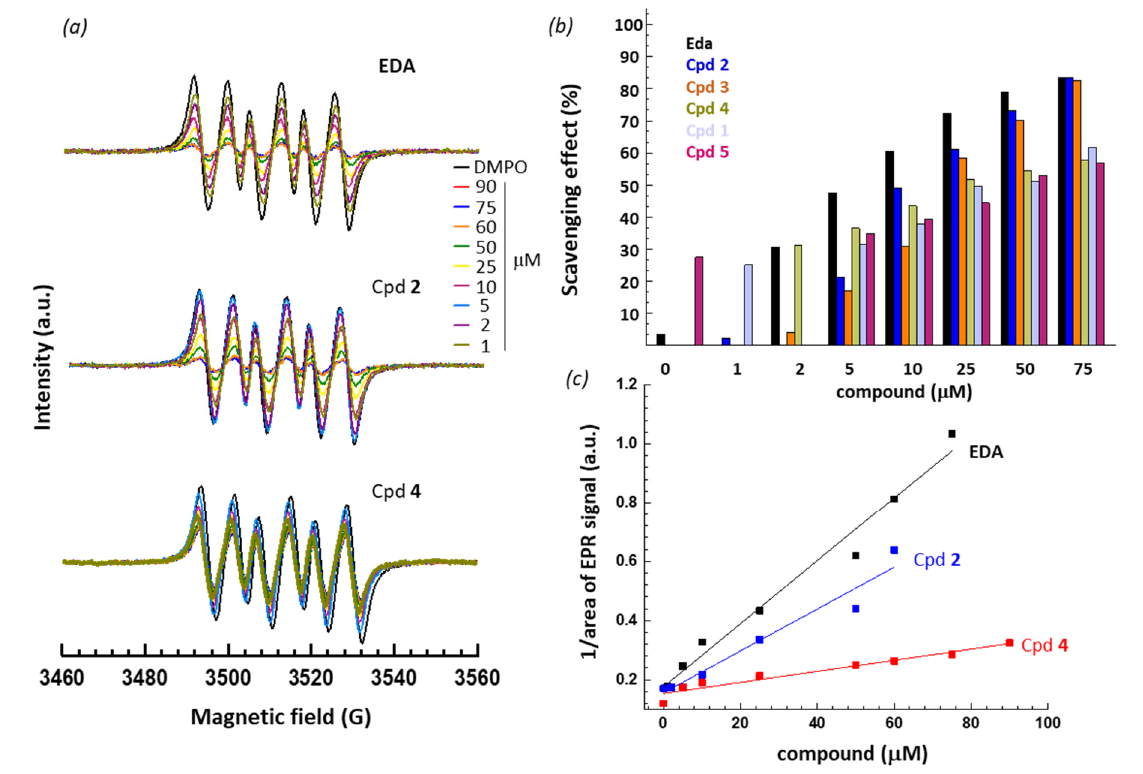
Figure 3. ( a ) EPR spectra of DMPO/ • OCH 3 radical in the presence of increasing amounts of the indi- cated compound. ( b ) Comparison of the scavenging effect (%) of the compounds. DMPO was used at 1 or 2 mM and the concentration of the test compound varied from 1 to 75 μ M, as indicated. The scavenging effect (%) was calculated from the ratio [area(DMPO/ • OCH 3 ) − area(DMPO/ • OCH 3 + test compound)]/area(DMPO/ • OCH 3 ). ( c ) Dose-response curve to compare the antioxidant capacity of compounds EDA, 2 and 4 . These plots were used to determine the reaction rate constant (k r ) (Table 1). The scavenging effect (%) is defined by the same ratio as mentioned above, as defined in the literature [29,30]. The goodness-of-fit values (r 2 calculated after linear regression) ranged from 0.960 to 0.999.